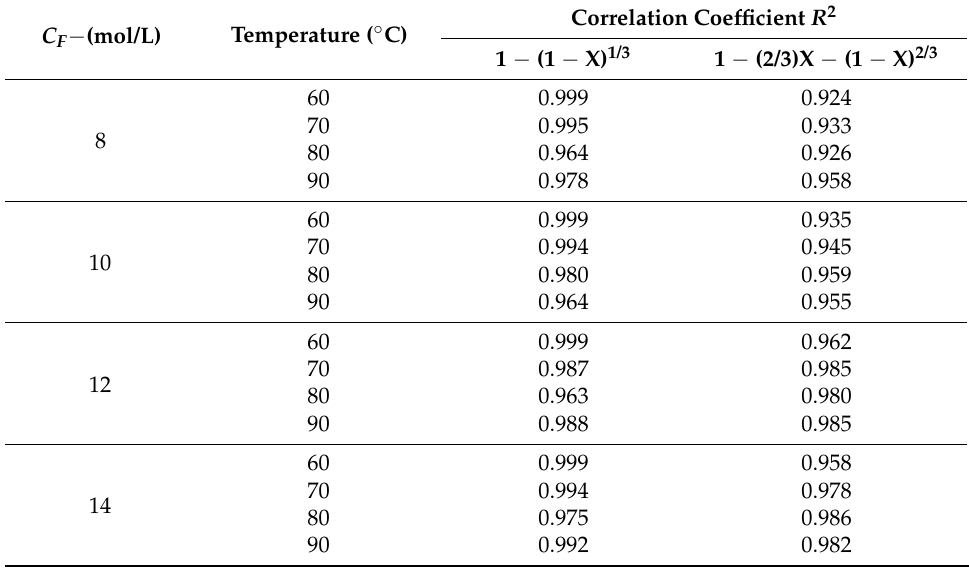
Table 3. Comparison of R 2 between plots of 1 − (1 − X) 1/3 and 1 − (2/3)X − (1 − X) 2/3 versus time for different F − concentrations and temperatures with L / S ratio of 20:1 and rotating speed of 200 r/min. C F −